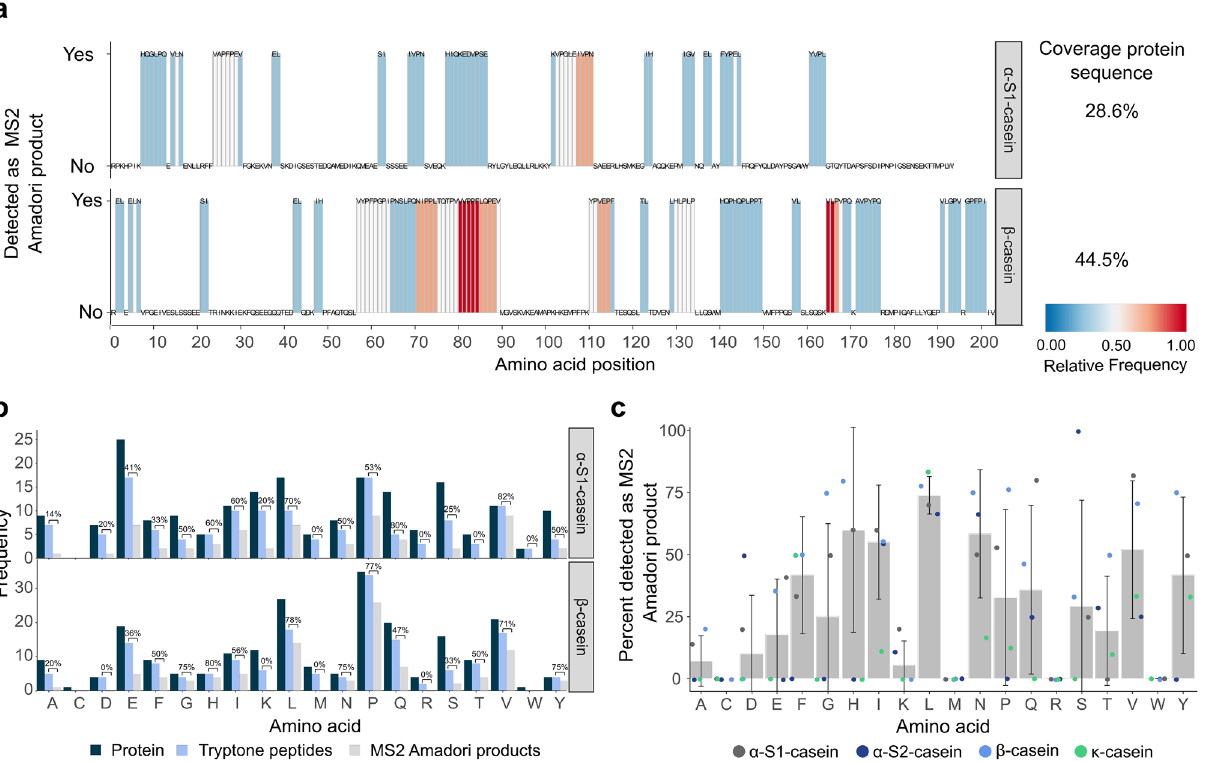
Figure 3. Deconvolution of glycated protein sequences reveals their compositional characteristics. (a) Contribution of protein regions and the amino acid microenvironment to peptide AP formation. Casein protein heatmaps represent the relative frequency of amino acid positions that were detected as an AP, indicating which peptides from specific protein regions contribute most to early MR and how the amino acid microenvironment influences peptide reaction behavior. Approximately 28.6% of α-S1- and 44.5% of β-casein were detected as the corresponding MS2 AP, and the majority contains redundant sequence motifs (i.e. P-E-V, see Fig. 4). ( b) Abundance of amino acids in casein proteins (dark blue), tryptone peptides (light blue) and APs (gray). Embedded values indicate the percentage of peptides that could also be detected as an AP. ( c) The bar plot depicts the median percentage of the amino acid found in APs in the different casein proteins. Overlaid points indicate the percentage for each studied casein protein. The whiskers represent the standard deviation.